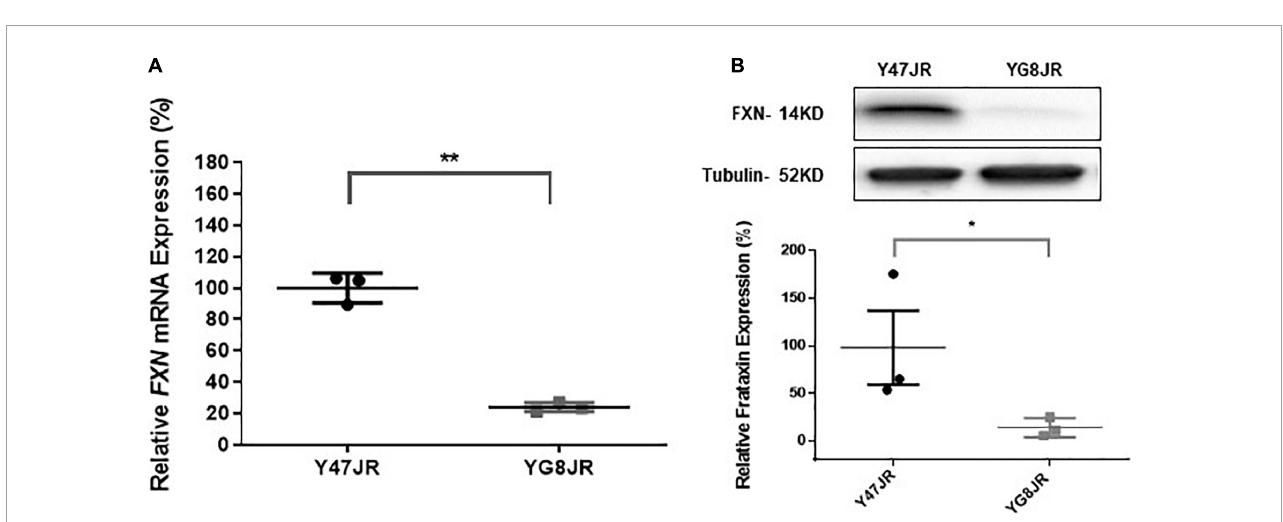
FIGURE3 Frataxin expression levels. (A) Quantitative RT-PCR analysis of FXN mRNA extracted from Y47JR control and YG8JR FRDA mouse brain tissues ( n = 3 per genotype) using mouse-human specific primers. The experiments were repeated 2–3 times for each genotype and performed in triplicates. Data were normalized to the mean frataxin level of Y47JR samples taken as 100%. Values represent mean ± SD. Asterisks indicate significant differences between YG8JR and Y47JR, assessed by unpaired two-tailed Student’s t -test (** p < 0.01). (B) Representative Western blot images and relative densitometric bar graphs of Frataxin in brain tissues of YG8JR FRDA and Y47JR control mice ( n = 3, 2–3 independent experiments). Tubulin was used as protein loading control. Data were normalized to the mean frataxin level of Y47JR samples taken as 100%. Values represent mean ± SD. Asterisks indicate significant differences between YG8JR and Y47JR, assessed by unpaired two-tailed Student’s t -test (* p <